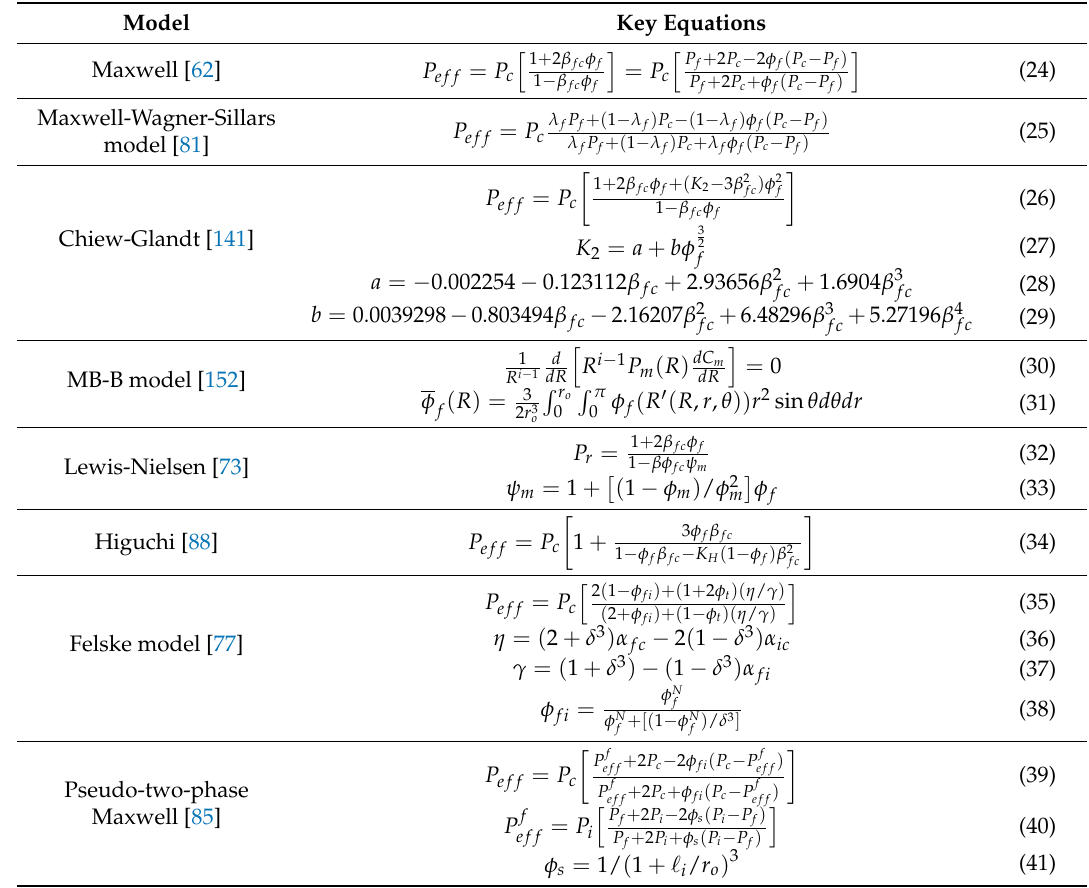
Table 2. Models based on Maxwell’s